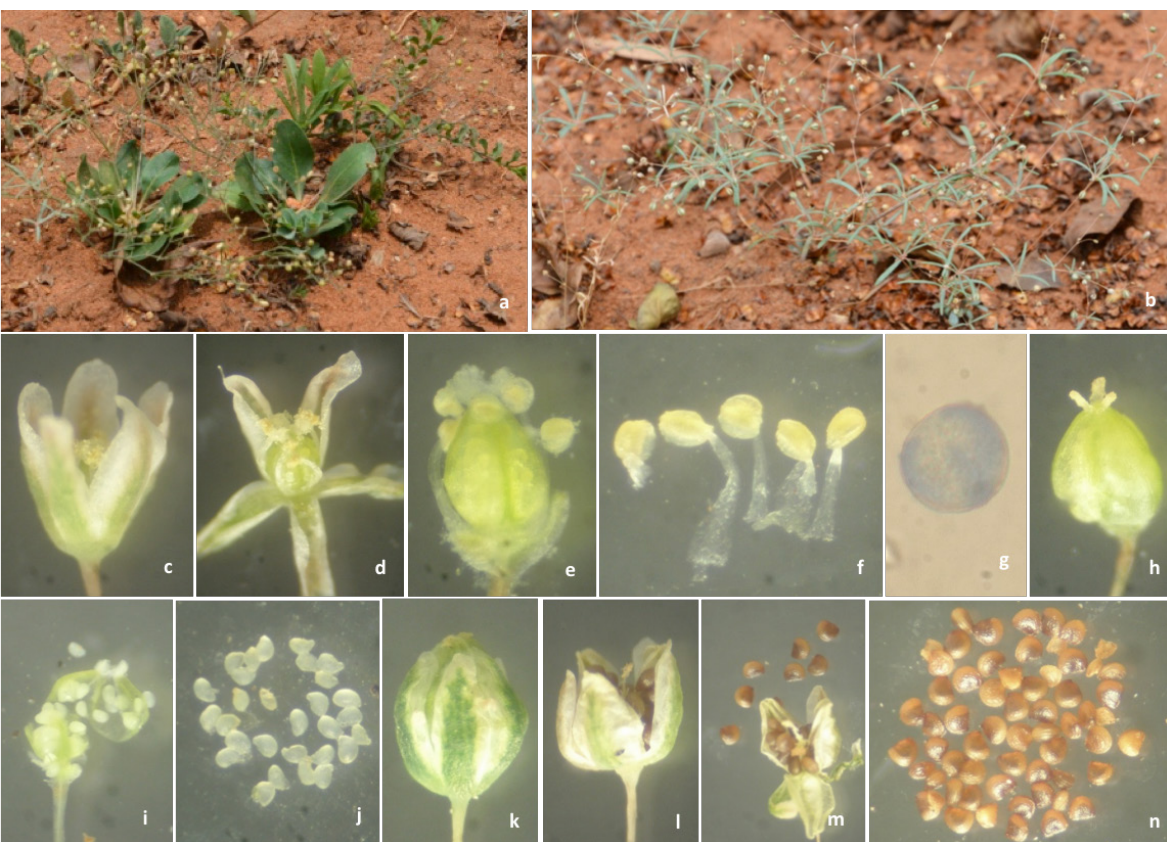
Image 1. Mollugo cerviana : a. Habitat with M. nudicaulis , b. flowering phase, c. & d. Flowering-opening phase, e. Position of stigmatic lobes and anthers at the same height contacting each other at anthesis, f. Dehisced anthers, g. Pollen grain, h. Ovary with three stigmas, i. & j. Multi-ovuled ovary, k. Maturing fruit, l. & m. Dehisced fruit capsule, n. Seeds. © A.J. Solomon